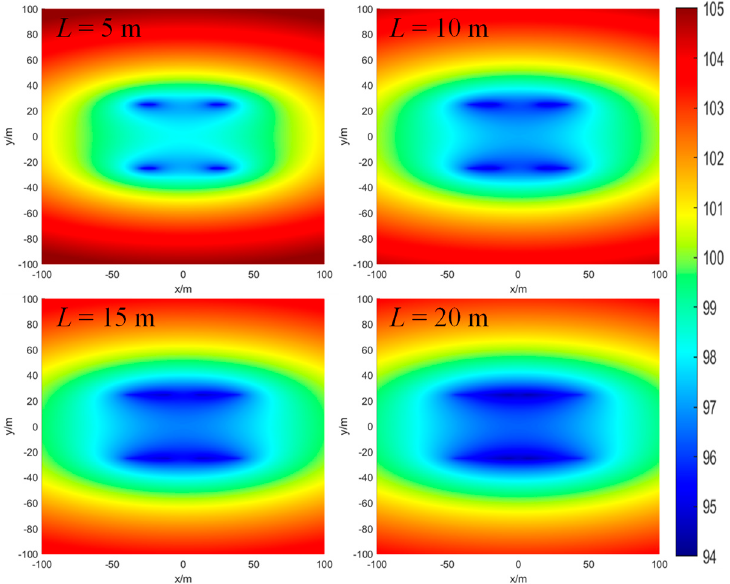
Figure 13. Pressure field distribution of coal seam under heterogeneous